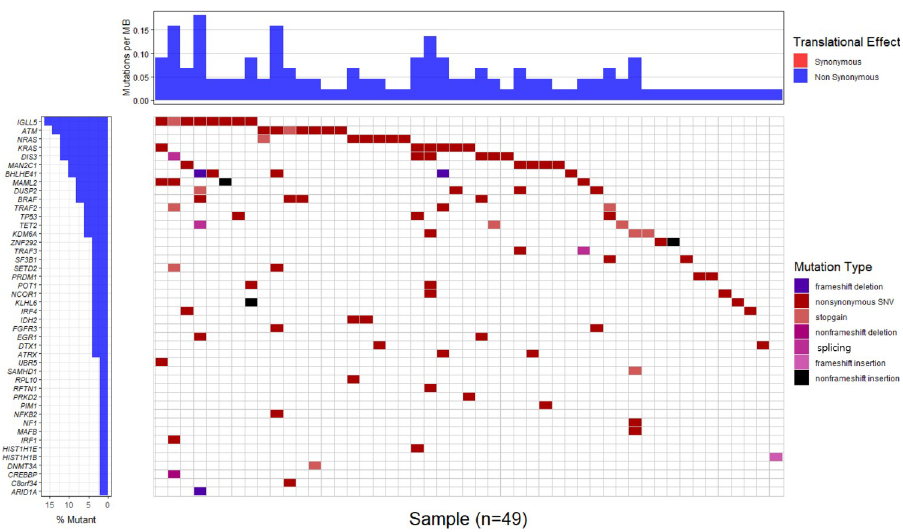
Fig 2. Frequency and distribution of somatic mutations in patients with NDMM. Mutation burden per megabase (Mb) in tumor are represented (upper) and mutated genes are ranked by mutant frequency (lower). The heatmap showed individual mutations in patient samples, color-coded by type of mutation. Genes with significant somatic mutations (pathogenic, likely pathogenic, and variants of unknown significance by ACMG guideline) are represented.